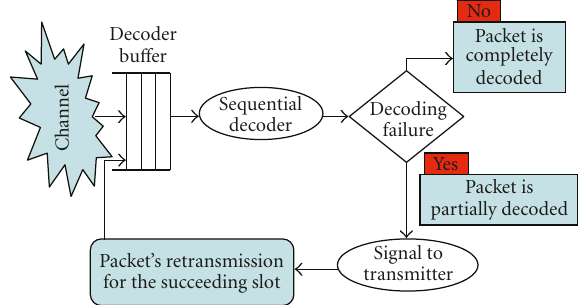
Figure 4: A router system with a sequential decoder using stop- and-wait ARQ.